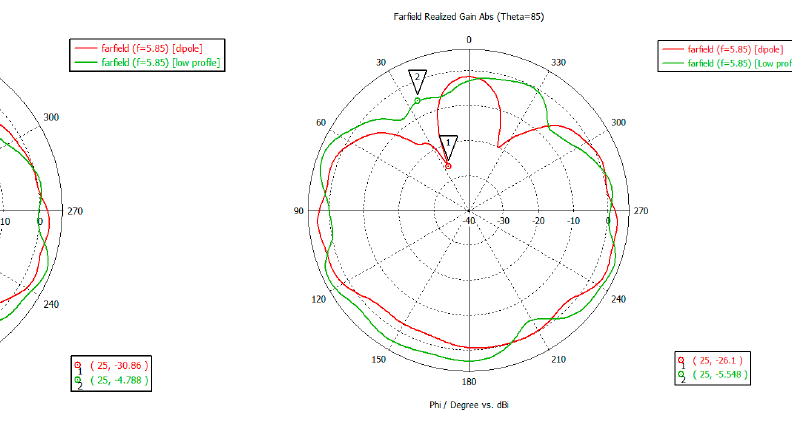
( c ) Figure 7. Two-dimensional null value comparison of monopole-only (red color) and monopole with quadruple closed-loop devices (green color) at the angles of ( a ) 80°; ( b ) 85°; and ( c ) 90°. ( a ) ( b ) Figure 8. Surface current when installed on the shark-fin module: ( a ) Monopole with quadruple closed-loop devices, and ( b ) monopole-only wave antenna. We also implemented monopole WAVE antennas with four closed-loop devices and characterized their properties to assess their practical applicability. The implemented mon- opole WAVE antenna was mounted on a shark-fin antenna (Figure 1c,d). Figure 9 shows the result of analyzing the beam pattern for smooth communication at 80°, i.e., the commu- nication between a vehicle on the road and a base station installed at a height of 6 m. A/m 2.4 1.8 1.5 A/m 3.6 2.6 2.2